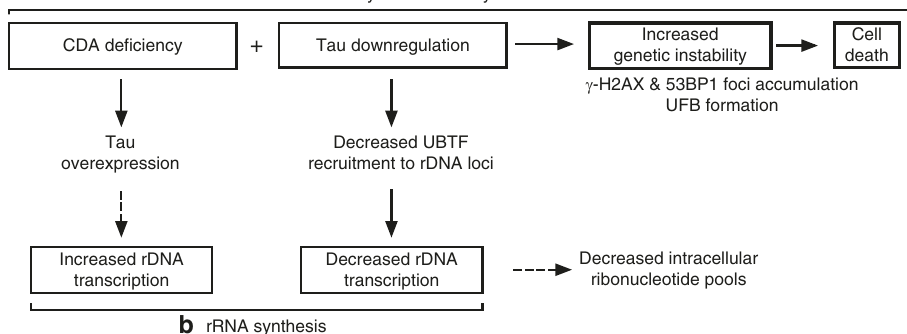
Fig. 6 Schematic model of the interactions between CDA and Tau. a The simultaneous silencing of Tau and CDA increased genetic instability, as illustrated by the increases in γ -H2AX and 53BP1 focus events and UFB frequency. The accumulation of DNA damage and replication stress led to a decrease in clonal growth, and, thus, to cell death. b Tau downregulation affected rRNA synthesis by decreasing UBTF recruitment to rDNA promoters, thereby impairing the transcription of rDNA. By contrast, Tau overexpression in CDA-de fi cient cells led to an increase in rDNA transcription. Finally, Tau downregulation decreased the size of the intracellular ribonucleotide pools, consistent with previous reports linking decreases in rRNA production to imbalances in ribonucleotide